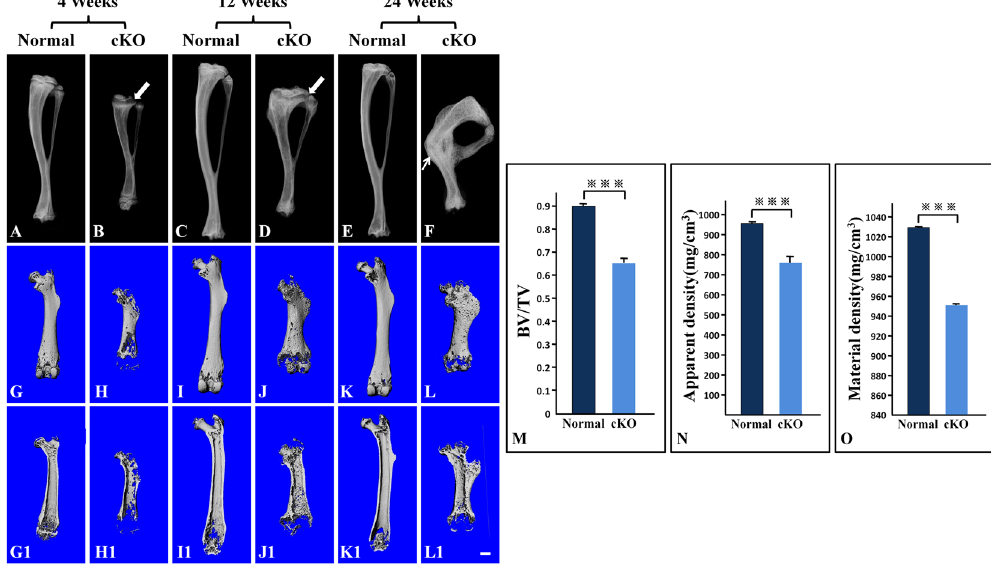
Figure 2. X-ray radiography analyses. ( A – F ) Plain X-ray radiographs of mouse tibias; arrows in ( B ) and ( D ) were pointing at the growth plate zones; arrow in ( F ) was pointing at a healed fracture. ( G – L ) whole views of µ CT scans for mouse femurs; ( G1 – L1 ) longitudinal section views of femurs; ( M – O ) quantitative analyses of data acquired from the high-resolution scans of the midshaft regions in the femurs from five mice (n = 5) at postnatal 12 weeks. Bar = 1.0 mm; *** P < 0.01. The long bones of cKO mice were shorter and had lower radiodensity compared to the age-matched normal mice ( A – F ). The growth plate zones (arrows in B and D ) appeared wider in the cKO mice than in the normal mice. The tibia of 24-week-old cKO mice had a fracture (arrow in F ), which appeared to have healed. The metaphysis regions of the femurs in the cKO mice were enlarged; the outer and inner bone surfaces of the long bones were more porous ( G–L , G1–L1 ). The cortical bone of cKO mice had significant reductions in BV/ TV ratio ( M ), Apparent Density ( N ) and Material Density ( O